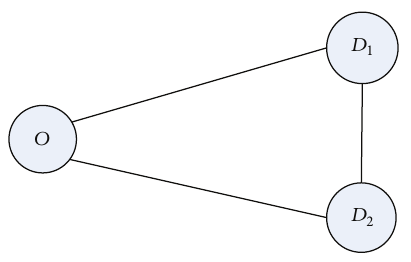
Figure 1: Travel routes of carpooling